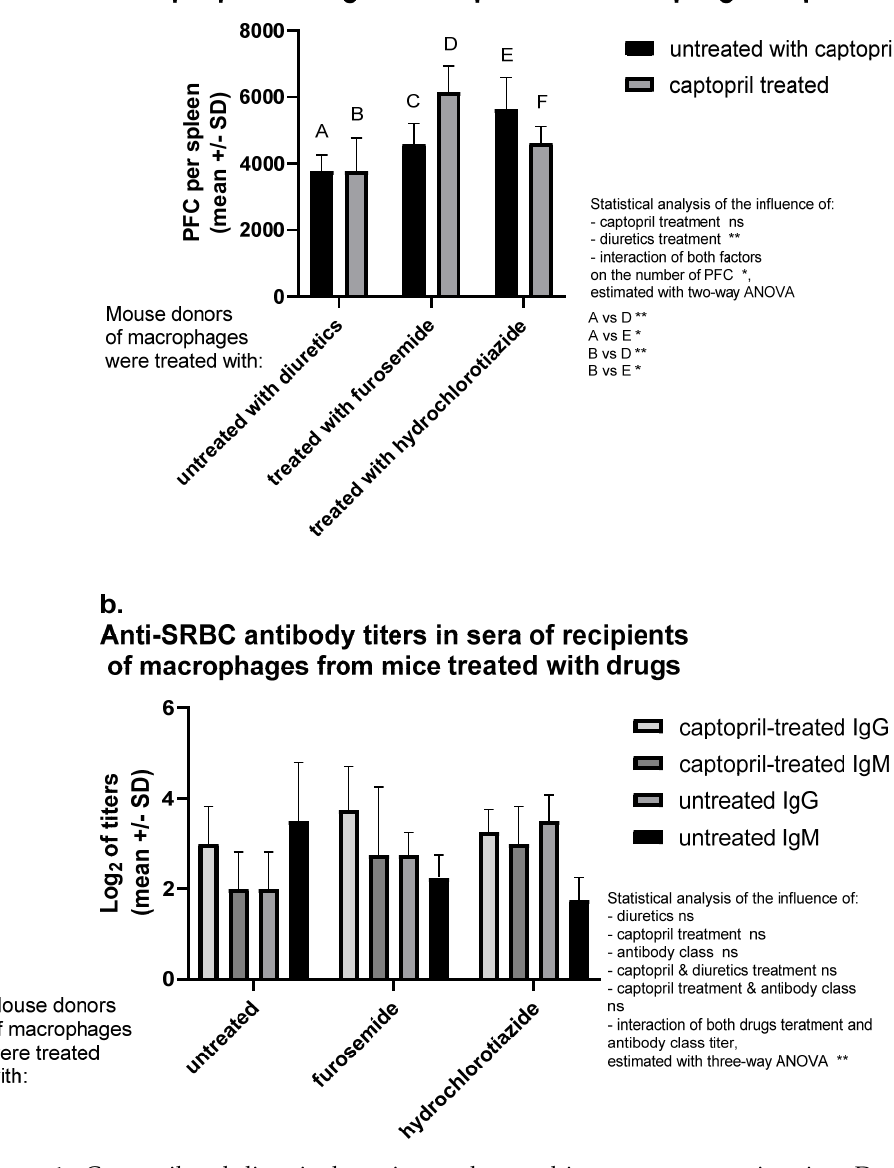
Figure 1. Captopril and diuretic drugs impact humoral immune response in mice. Donors of mac- rophages were treated intraperitoneally with captopril with or without furosemide or hydrochlo- rothiazide for eight days. Then, oil-induced peritoneal macrophages, after pulsing with sheep red blood cells (SRBC), were transferred intraperitoneally into recipients, from which sera and spleens were collected individually seven days later. ( a ) Number of plaque-forming cells (PFC) expressing SRBC-specific antibody-producing B cells in spleens of macrophage recipients was estimated through a plaque-forming assay and indicated as a mean number of PFC per spleen. ( b ) SRBC-specific antibody titers in sera of recipient mice were assessed through a direct hemaggluti- nation assay and expressed as a mean value of log2 of antibody titer. Two-way or three-way ANOVA with Tukey post hoc test. * p < 0.05; ** p < 0.01; ns—not